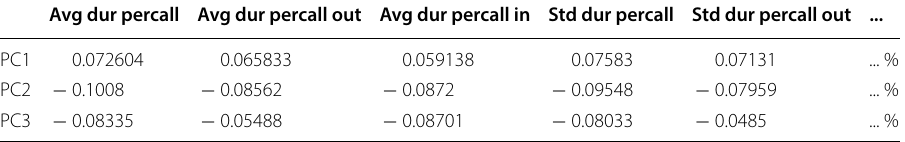
Table 5 Variables contributions to the principal